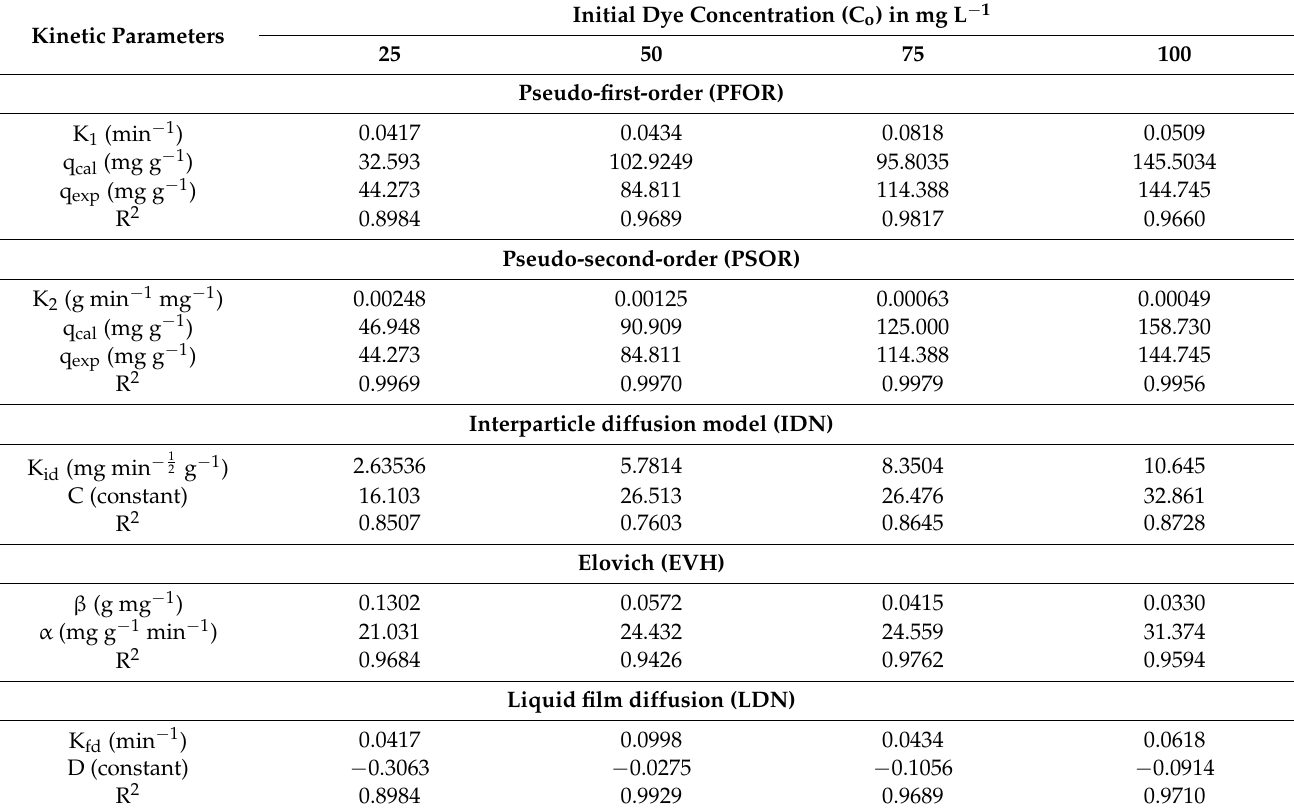
Table 1. Kinetic parameters for the adsorption of CV onto AISD (experimental conditions: